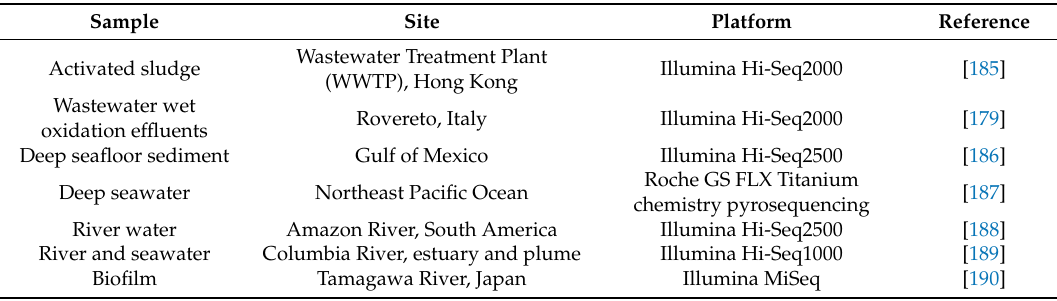
Table 5. The applications of metatranscriptomic sequencing on microbial communities in wastewater and water